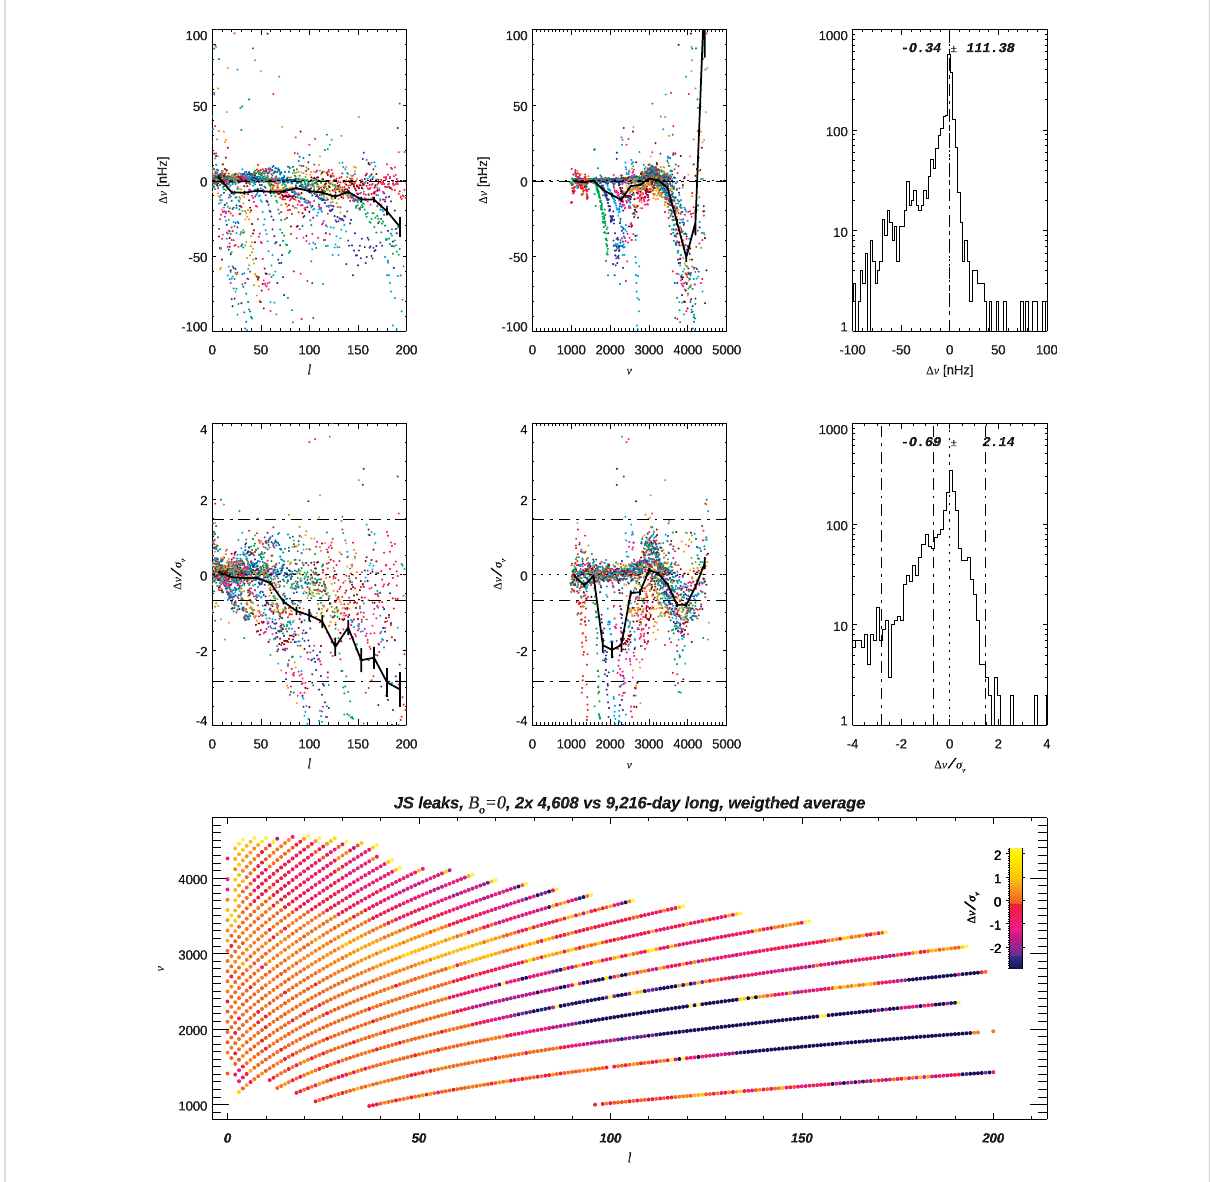
FIGURE 7 Comparison of multiplets when fi tting and then averaging two abutting 4,608-day-long time series to the corresponding 9,216-day-long time series, using the same leakage matrix.